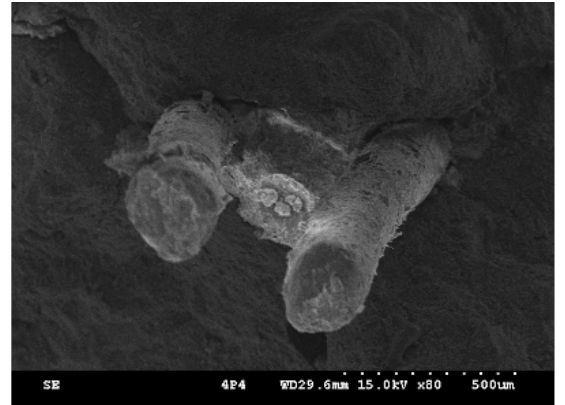
Figure 9. SEM photo of the specimens containing 40% slag.